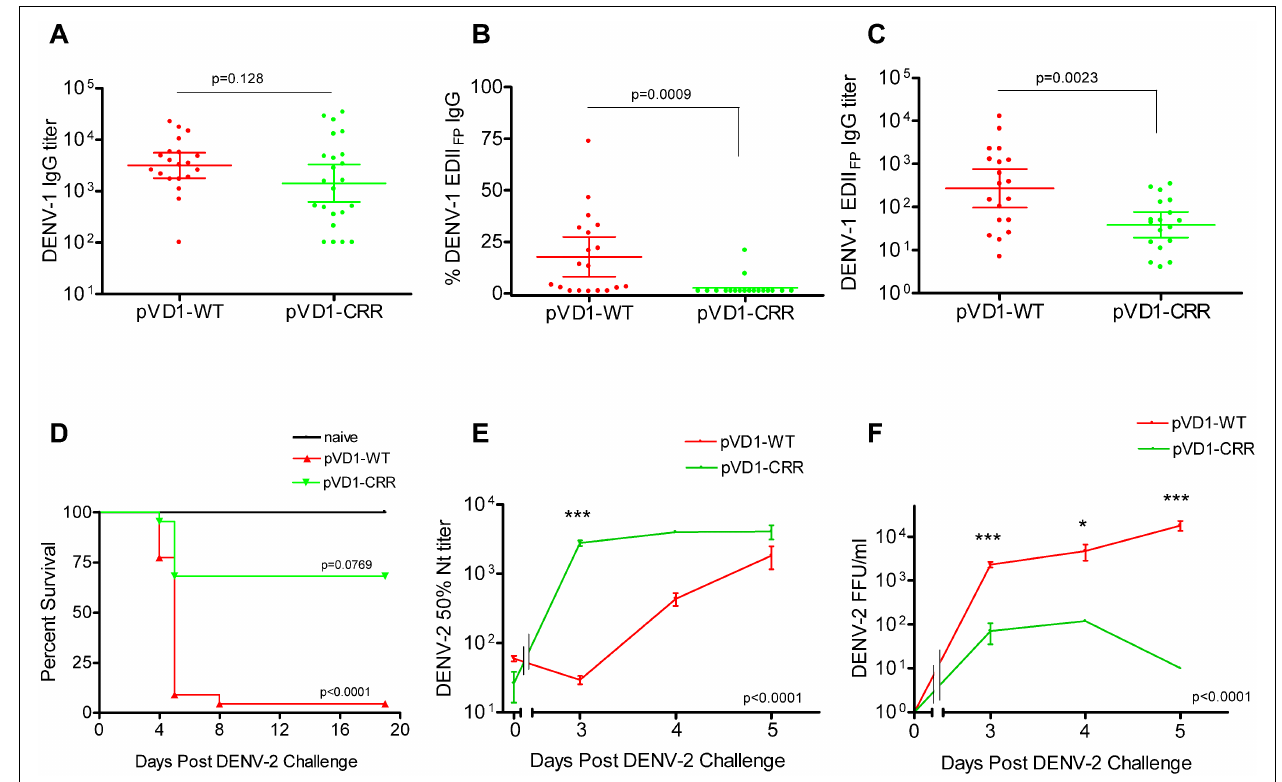
FIGURE 3 | DENV-1 CRR vaccine stimulates reduced levels of immunodominant cross-reactive EDII FP IgG and reduces enhanced DENV-2 mortality. (A–C) 12 week post vaccination immunogenicity of AG129 mice immunized (i.m.) with 100 μ g of pVD1-WT or pVD1-CRR vaccines. Geometric means and 95% confidence intervals are depicted. Endpoint titers were log 10 transformed and statistical significance was determined using the two-tailed Mann–Whitney U test. Panels B and C both used a one-tailed test since there was an a priori expectation that pVD1-CRR immunized mice would exhibit reduced EDII FP recognizing IgG. (A) DENV-1 total IgG endpoint titers 12 weeks post immunization. (B) Percent of total DENV-1 IgG recognizing immunodominant EDII FP epitopes, arithmetic means and 95% CI depicted. (C) Calculated DENV-1 EDII FP IgG endpoint titers. (D) Survival of pVD1-WT and pVD1-CRR immunized AG129 mice following sub-lethal heterologous DENV-2 challenge. 12 weeks following vaccination, immunized mice ( n = 22) or age matched naïve controls ( n = 8) were challenged (i.p.) with 4.2 × 10 5 FFU of DENV-2 S221. Kaplan-Meier survival curves and p values are shown. All naïve mice survived virus challenge with minimal signs of morbidity, pVD1-WT vaccinated mice suffered 95% mortality